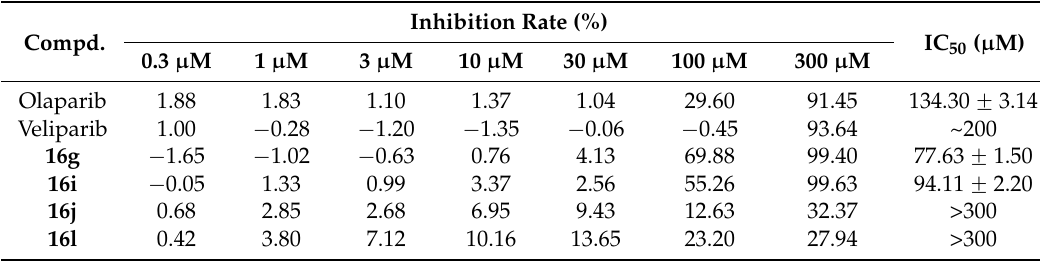
Table 5. The results of cytotoxicity assay on normal human lung fibroblast cells. a,b